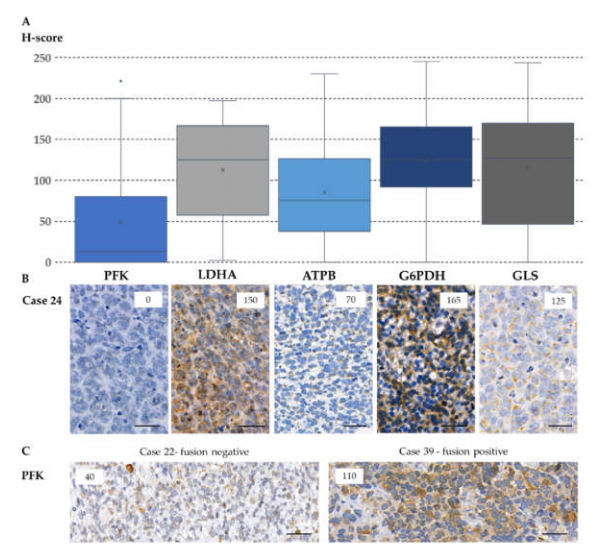
Figure 4. The metabolic marker expressions in primary rhabdomyosarcoma cases. The evaluation of metabolic markers in primary rhabdomyosarcomas showed that PFK and ATPB staining intensity remained mainly low; however, LDHA, G6PDH, and GLS stainings showed higher expression in most cases ( A ). Under the diagram, a representative case (case 24—a primary, fusion-negative case) is presented ( B ). The numbers in the right upper corner of the pictures refer to the given H-scores. All stainings are cytoplasmatic; however, ATPB and GLS show granular patterns due to their mitochondrial localization. DAB (brown) and hematoxylin (blue) were used as chromogen and counterstaining, respectively. Pictures were taken with CaseViewer 2.3 software (3DHistech Ltd., Budapest, Hungary), the scale bars show 25 µ m. Metabolic enzyme expression profiles of fusion negative and positive cases di ff ered only in PFK expression, which expressed at significantly higher level in fusion positive cases ( p = 0.033), which were demonstrated in two representative cases ( C ).